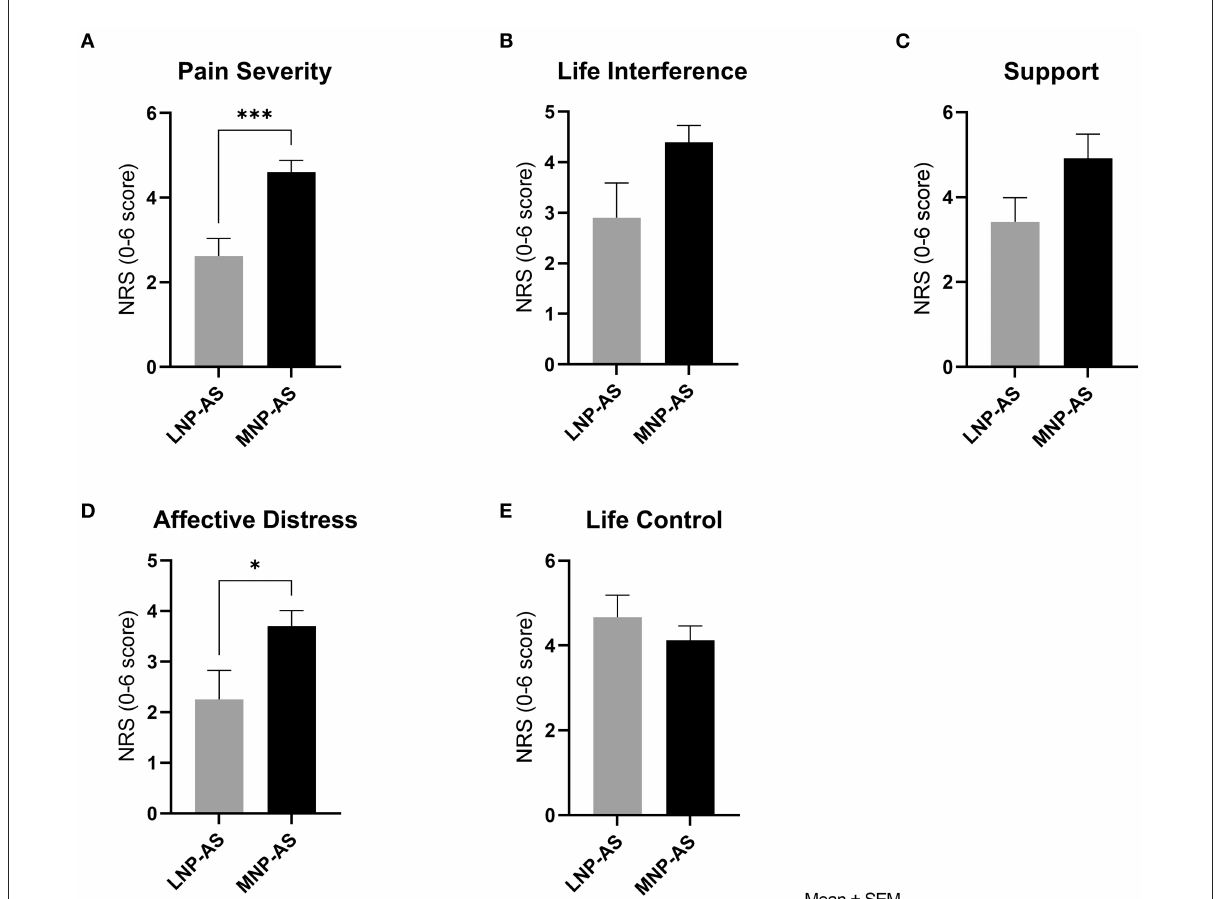
FIGURE5 Psychosocial function. Comparison of phenotypes with respect to the Multidimensional Pain Inventory subscales: (A) pain severity, (B) life interference, (C) support, (D) affective distress and (E) life control. LNP-AS, low or no neuropathic pain-anxiety symptoms. MNP-AS, moderate neuropathic pain-anxiety symptoms. * p < 0.05, *** p < 0.001.